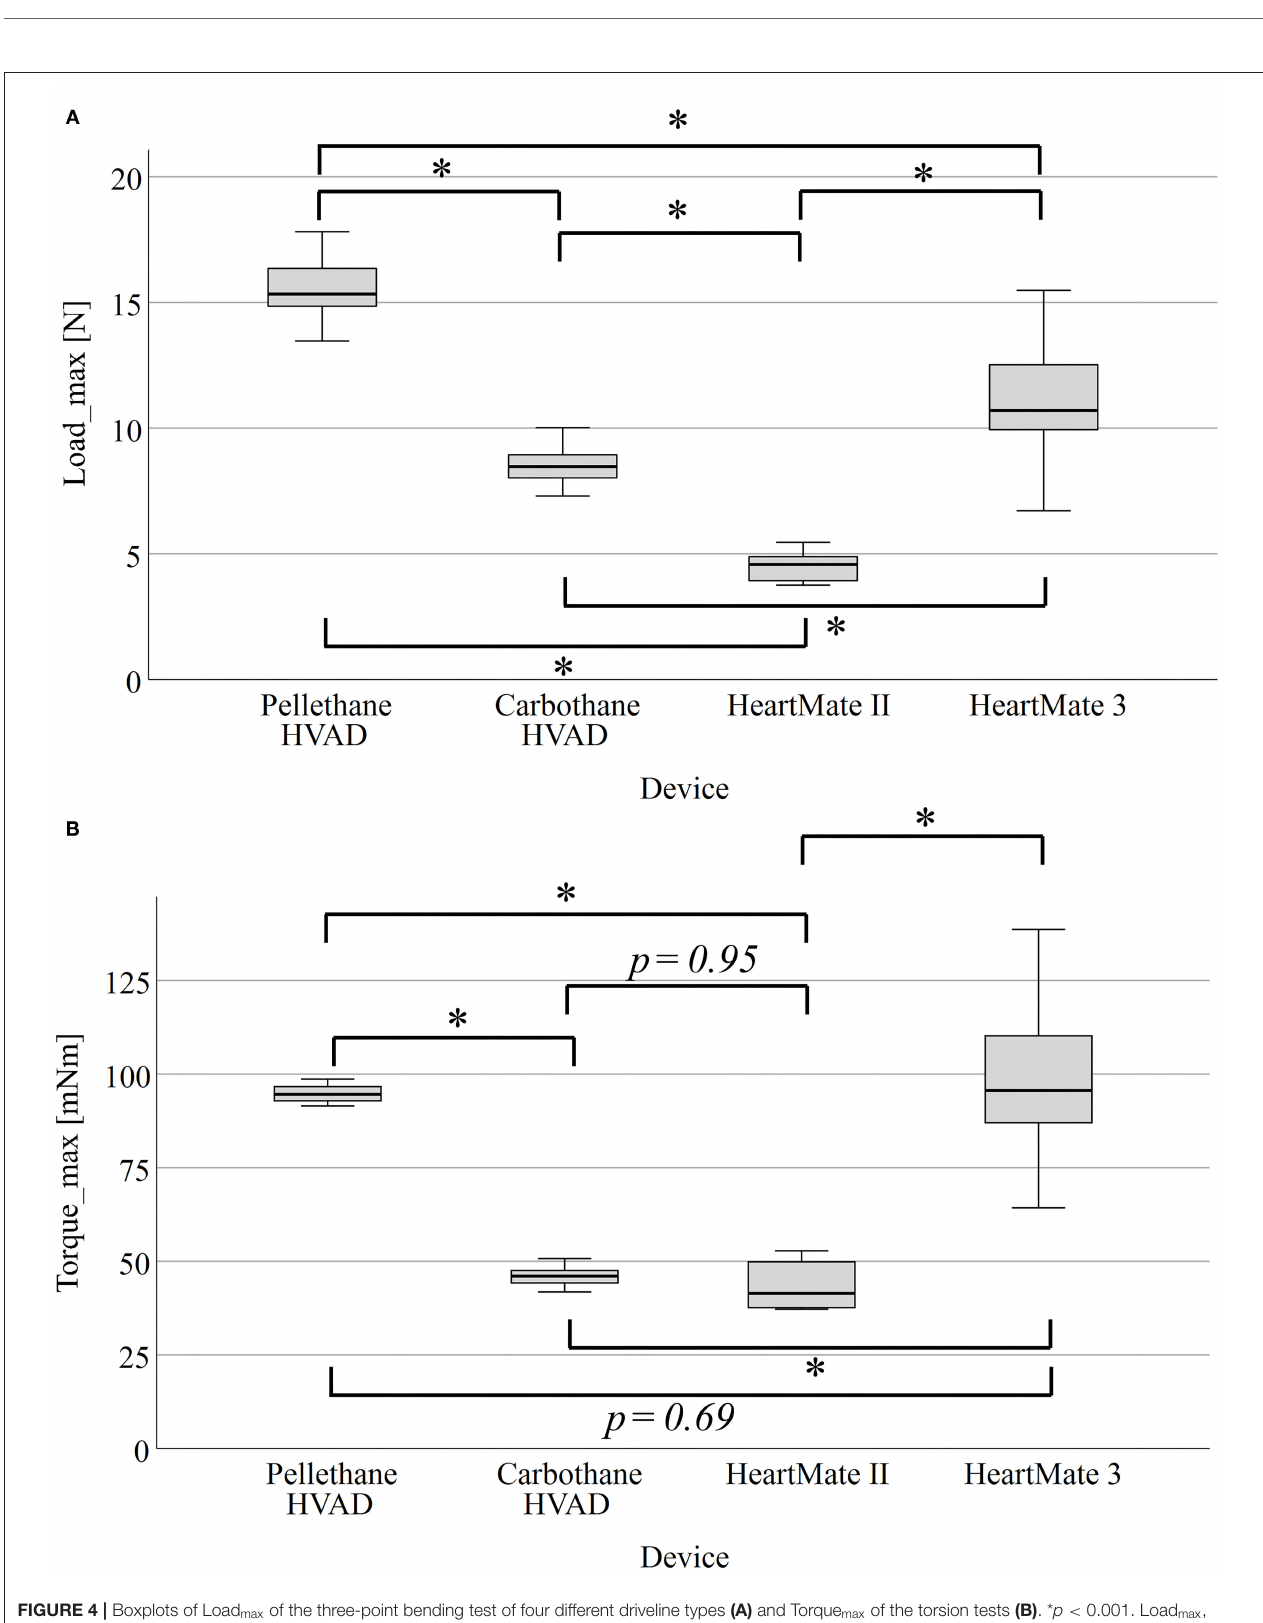
Frontiers in Cardiovascular Medicine |